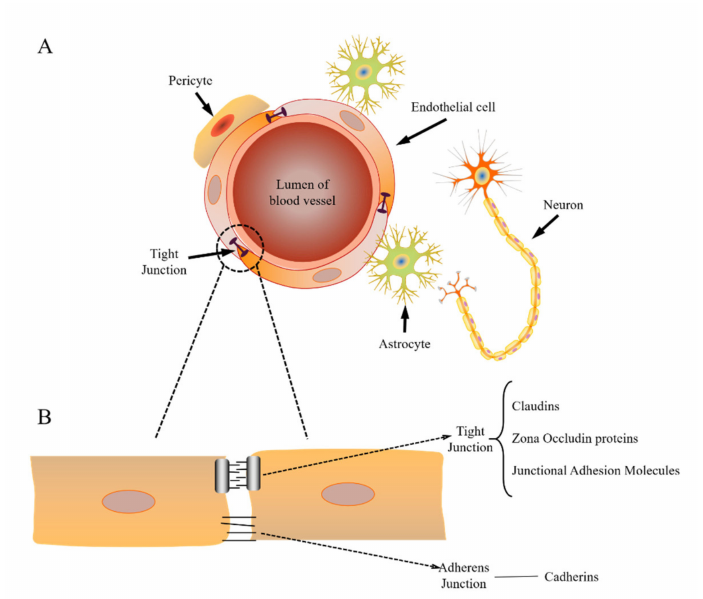
Figure 1. ( A ) Schematic of structure and components of the BBB. ( B ) Structure of endothelial intercellular junctions (including tight junctions (TJs) and adherens junctions (AJs)).